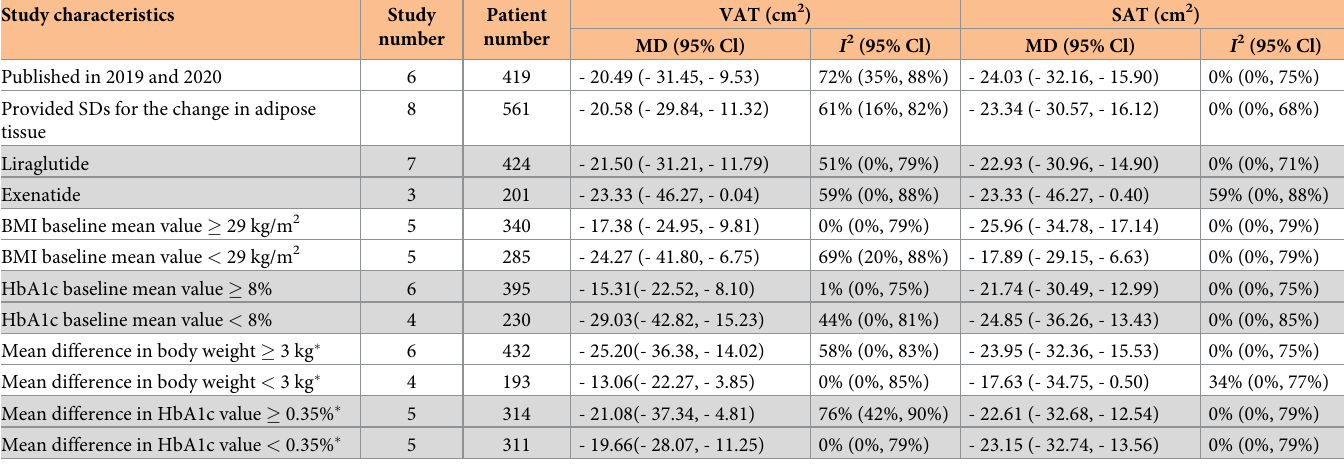
Table 2. Sensitivity and subgroup